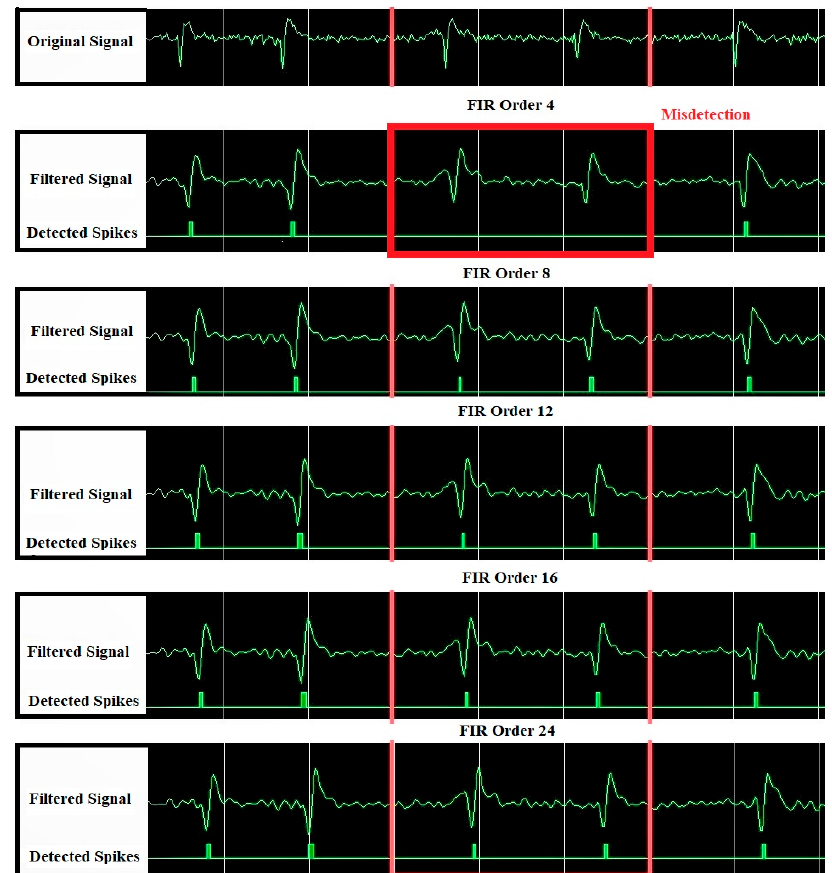
Figure 3. Misdetection of some spikes when using FIR of order 4.